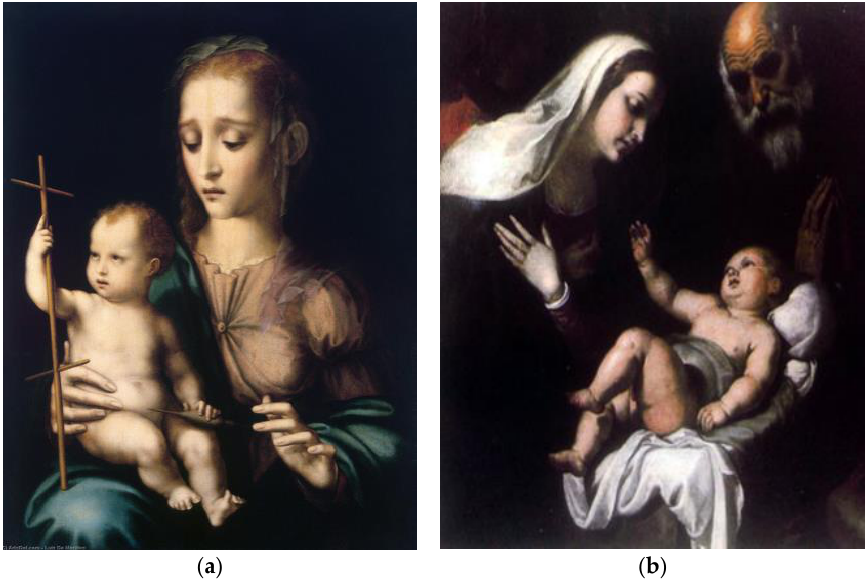
Figure A2. ( a ). Luis de Morales, “Virgen con el niño,” 1570, The Hermitage (St. Petersburg, Russia). ( left ) ; ( b ). Francisco Ribalta, “Nacimiento,” 1565– 1628, Colegio del Corpus Christi (Valencia, Spain). ( right ).